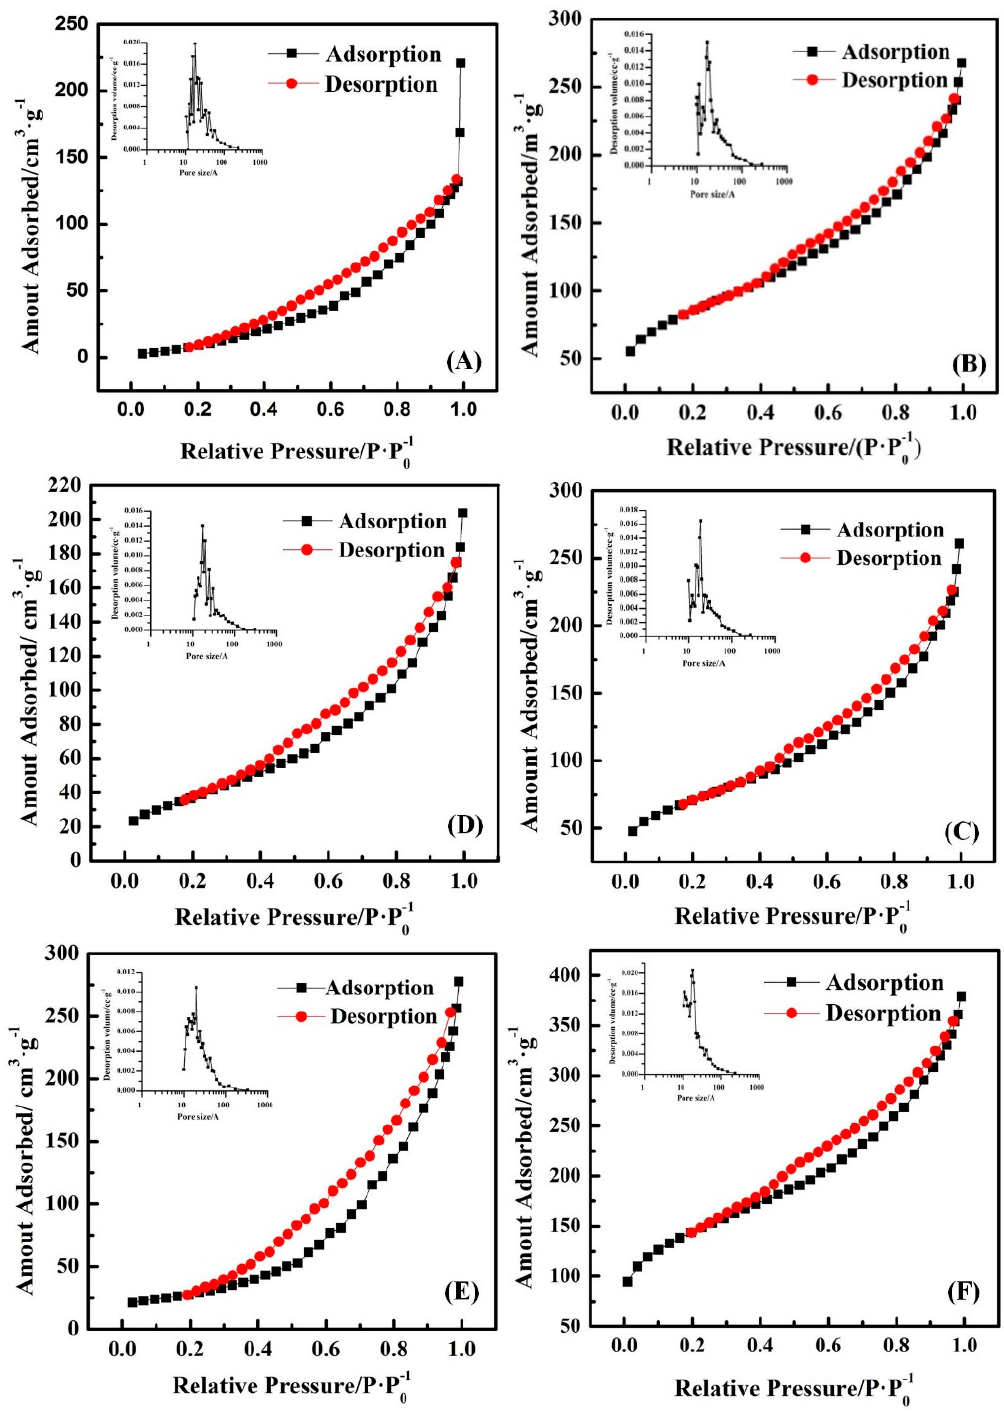
Figure 3. Adsorption-desorption isotherms of N 2 of the adsorbents. PPy ( A ); 0.1-PPy/GAC ( B ); 0.2-PPy/GAC ( C ); 0.5-PPy/GAC ( D ); 1-PPy/GAC ( E ) and GAC ( F ).